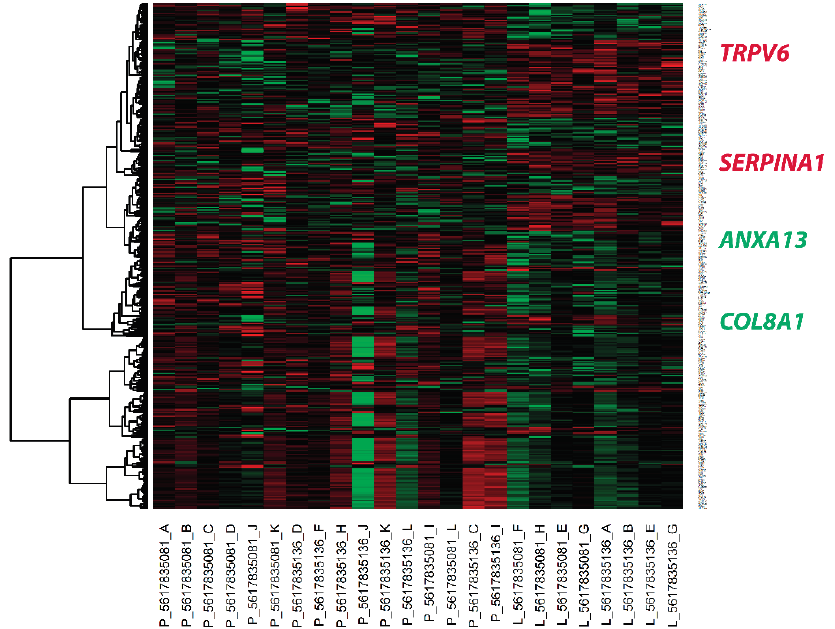
Figure 3. Heat map of differential gene expression between LN patients with or without loss of kidney function. The upregulated genes are shown in red, while the downregulated genes are shown in green. Each column represents an individual kidney sample. P: preserved kidney function; L: loss of kidney function. Gene names are indicated on the right. All validated candidate biomarkers are highlighted in green text for upregulated genes and red text for downregulated